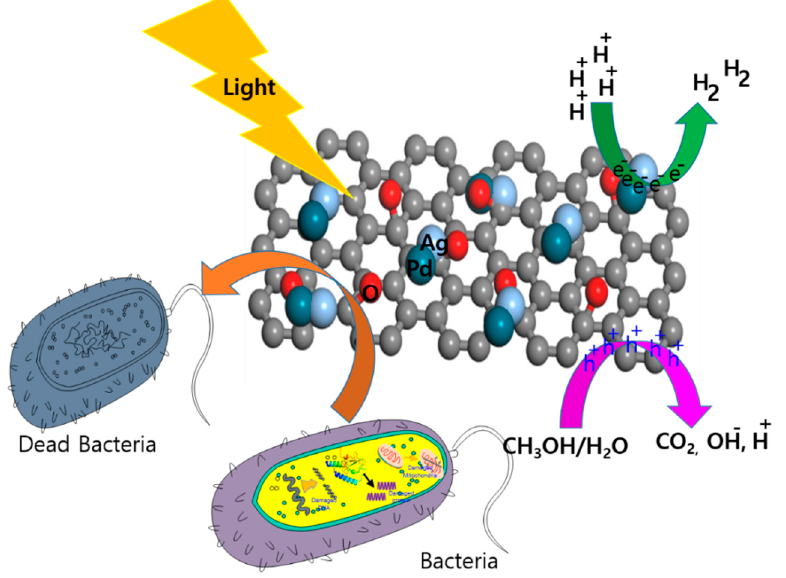
Figure 8. Schematic representation of photocatalytic H 2 production and hypothetical antimicrobial mechanism of prepared catalysts. mechanism of prepared